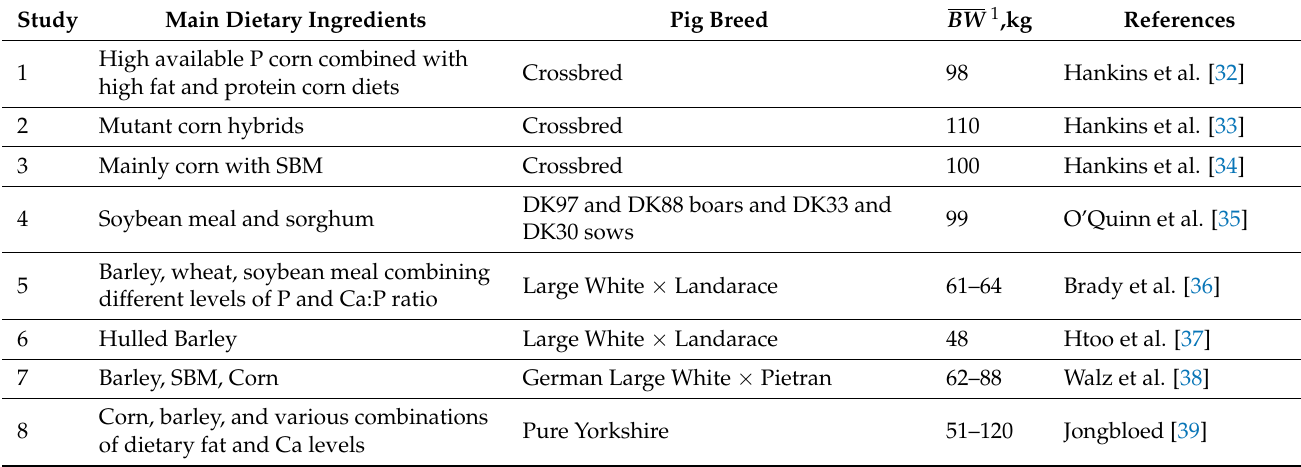
Table A1. Data description of studies generated from the literature in order to evaluate the ability of linear and non-linear models to describe phosphorus retention in growing and finishing